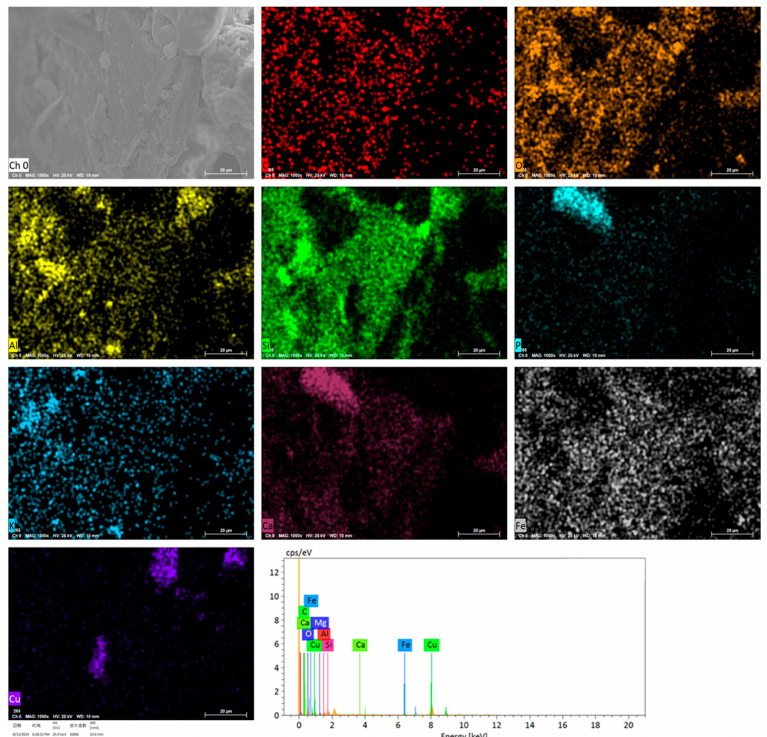
Figure 9. SEM image and the corresponding EDS mapping of SASs after adsorption